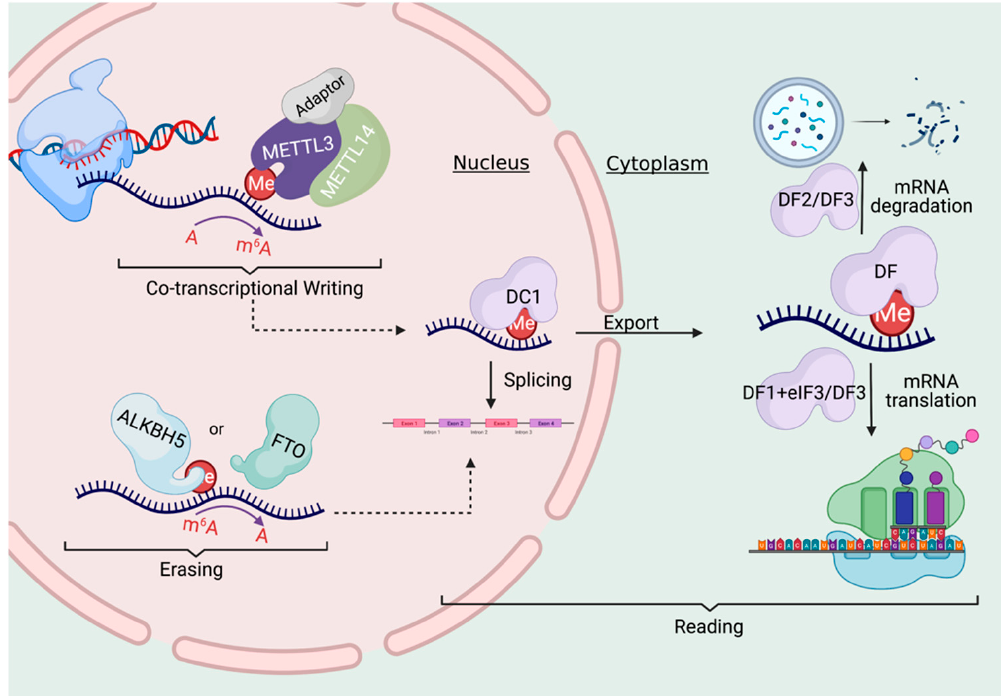
Figure 1. METTL3 catalyzes m 6 A methylation (Me) co-transcriptionally within the nucleus which is facilitated by its interacting partner, METTL14, and a number of adaptor proteins that enhance its activity. A modification upon a mRNA derives in large part by the effects of reader proteins such as the YTH domain-containing RNA binding proteins, and ultimately may lead to mRNA splicing, export, degradation, or translation. For example, while YTHDC1 (DC1) exists in the nucleus to promote nuclear export, YTHDF readers can preferentially promote degradation (i.e., YTHDF2, or “DF2”) or translation (i.e., YTHDF1 and YTHDF3, or “DF1” and DF3” here). Alternatively, m 6 A can also be demethylated by ALKBH5 and FTO in the